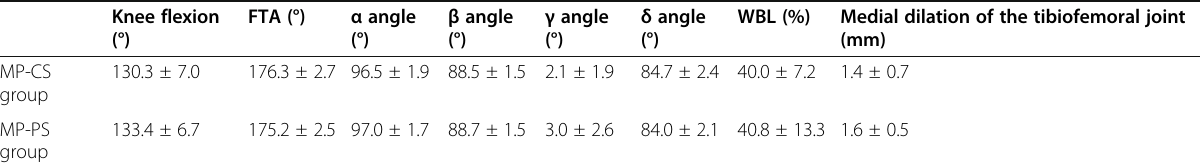
Table 3 Comparison of knee flexion angle and radiographic measurements at 1 year after surgery Knee flexion (°)